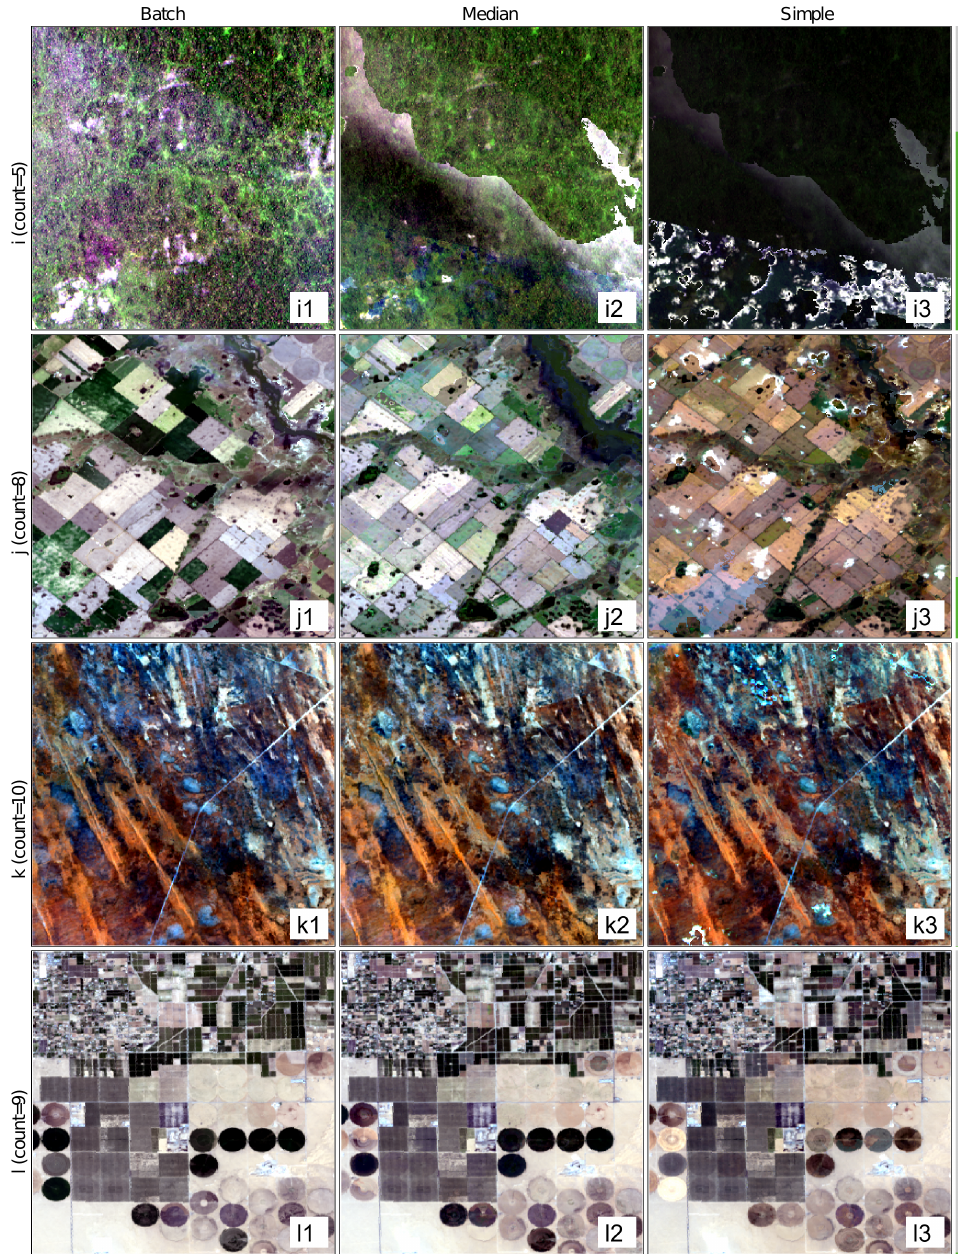
Figure 10. Visual comparison part 3: band 4/3/2 composition produced using different algorithms at locations from ( i – l ). Each location discloses the number of available image scenes (count variable from the left edge) and the average cloud coverage. The latter is represented by the vertical progress bar (max is 100%) on the right edge; ( i1 , j1 , k1 , l1 ) are produced with the batch algorithm, ( i2 , j2 , k2 , l2 ) are produced with the median algorithm, and ( i3 , j3 , k3 , l3 ) are produced with the simple algorithm. Band computations, such as NDVI, NDBI, and NDWI, were calculated from 5000 pix- els, which were randomly selected from the visualization images as shown in Figure 11. The majority of the post-banding data of the batch algorithm were derived from the one-view image and a small amount of missing data were derived from the observations where the substitutes were located (Figure 11a,d,g). In contrast, the median (Figure 11b,e,h) and simple (Figure 11c,f,i) algorithms have scattered data sources and different bands from different observations, which brings uncertainty to the results of the band